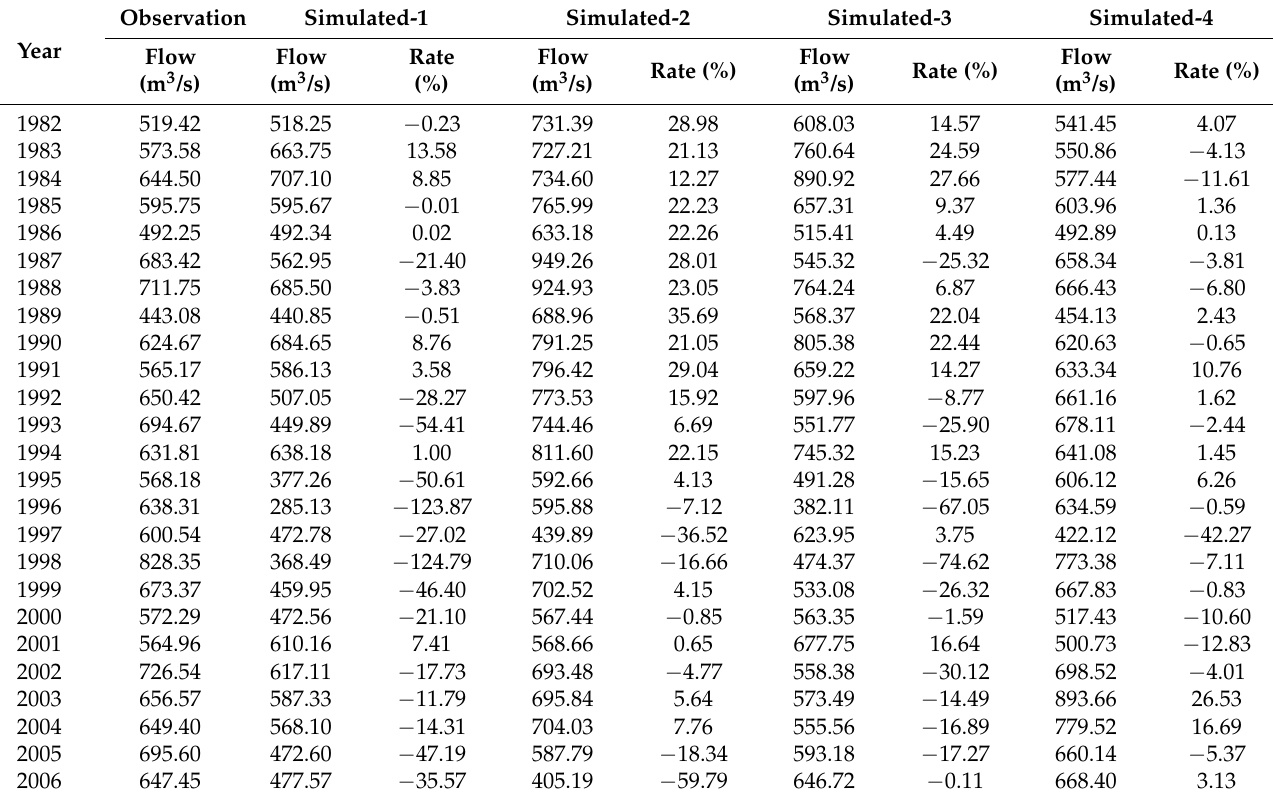
Table 2. Average annual simulated flow of four different simulation results from SWAT–CUP and their rates, compared to observational flow at the Darband hydrological station over the period of 1982–2006 in the Upper Vakhsh River Basin in Central Asia. Simulated-1: results of the combination of the APHRODITE_V1101 precipitation datasets and CFSR maximum/minimum temperature datasets; Simulated-2: results of the combination of the APHRODITE_V1101 precipitation datasets and CRU TS3.1 maximum/minimum temperatures datasets; Simulated-3: results of the CFSR